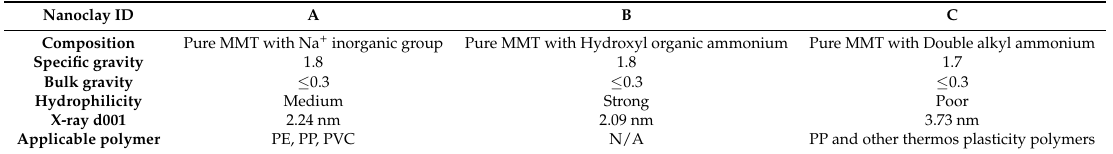
Table 2. Composition of different modified asphalt rubber samples Binder type